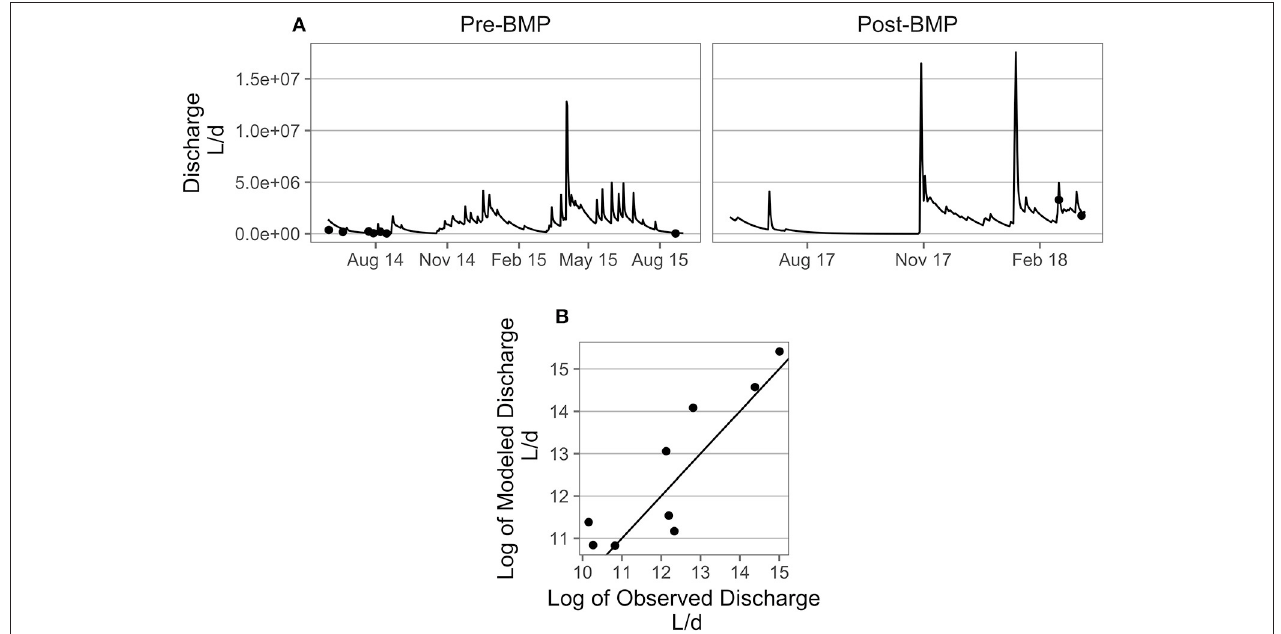
FIGURE 2 | (A) Observed and simulated flow values (mm/d) (points and lines, respectively) over study duration. (B) represents the relationship between observed to simulated flow on a log-log plot to ensure the model fits well for the more frequent low flow scenarios. The line shown is the 1 to 1 line between simulated and observed flows. NSE = 0.82.